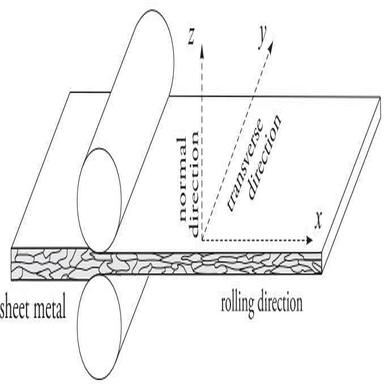
A schematic representation of the material coordinate system, with the x, y, and z axes corresponding to the rolling, transverse, and normal direction, respectively.